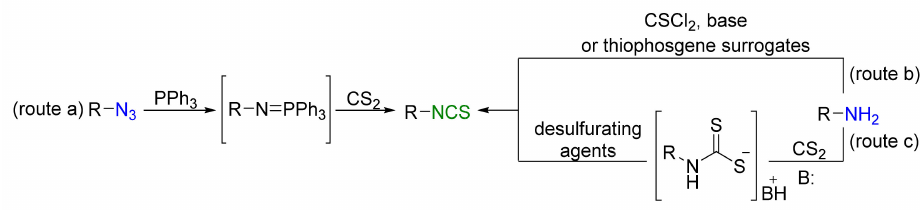
Figure 1. Methods of synthesizing isothiocyanates.